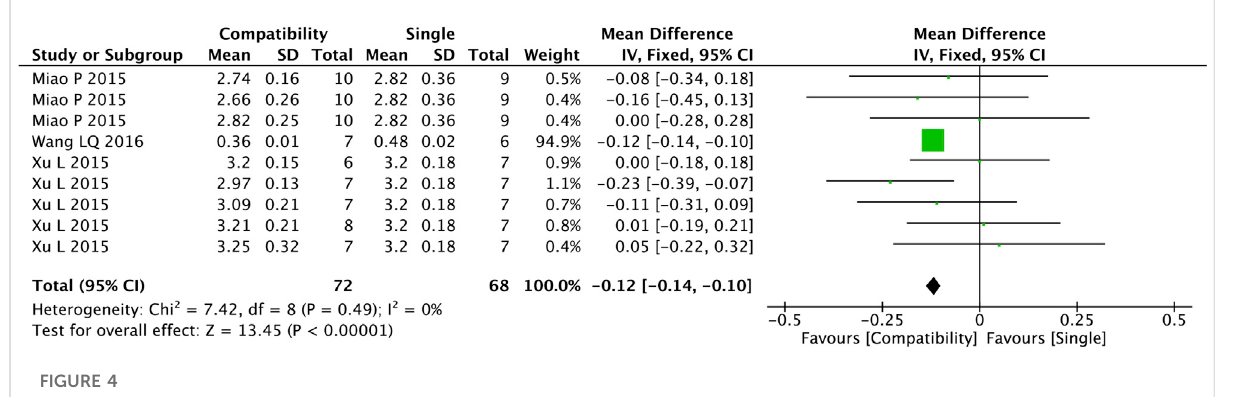
FIGURE 4 Forest plot of HWI.